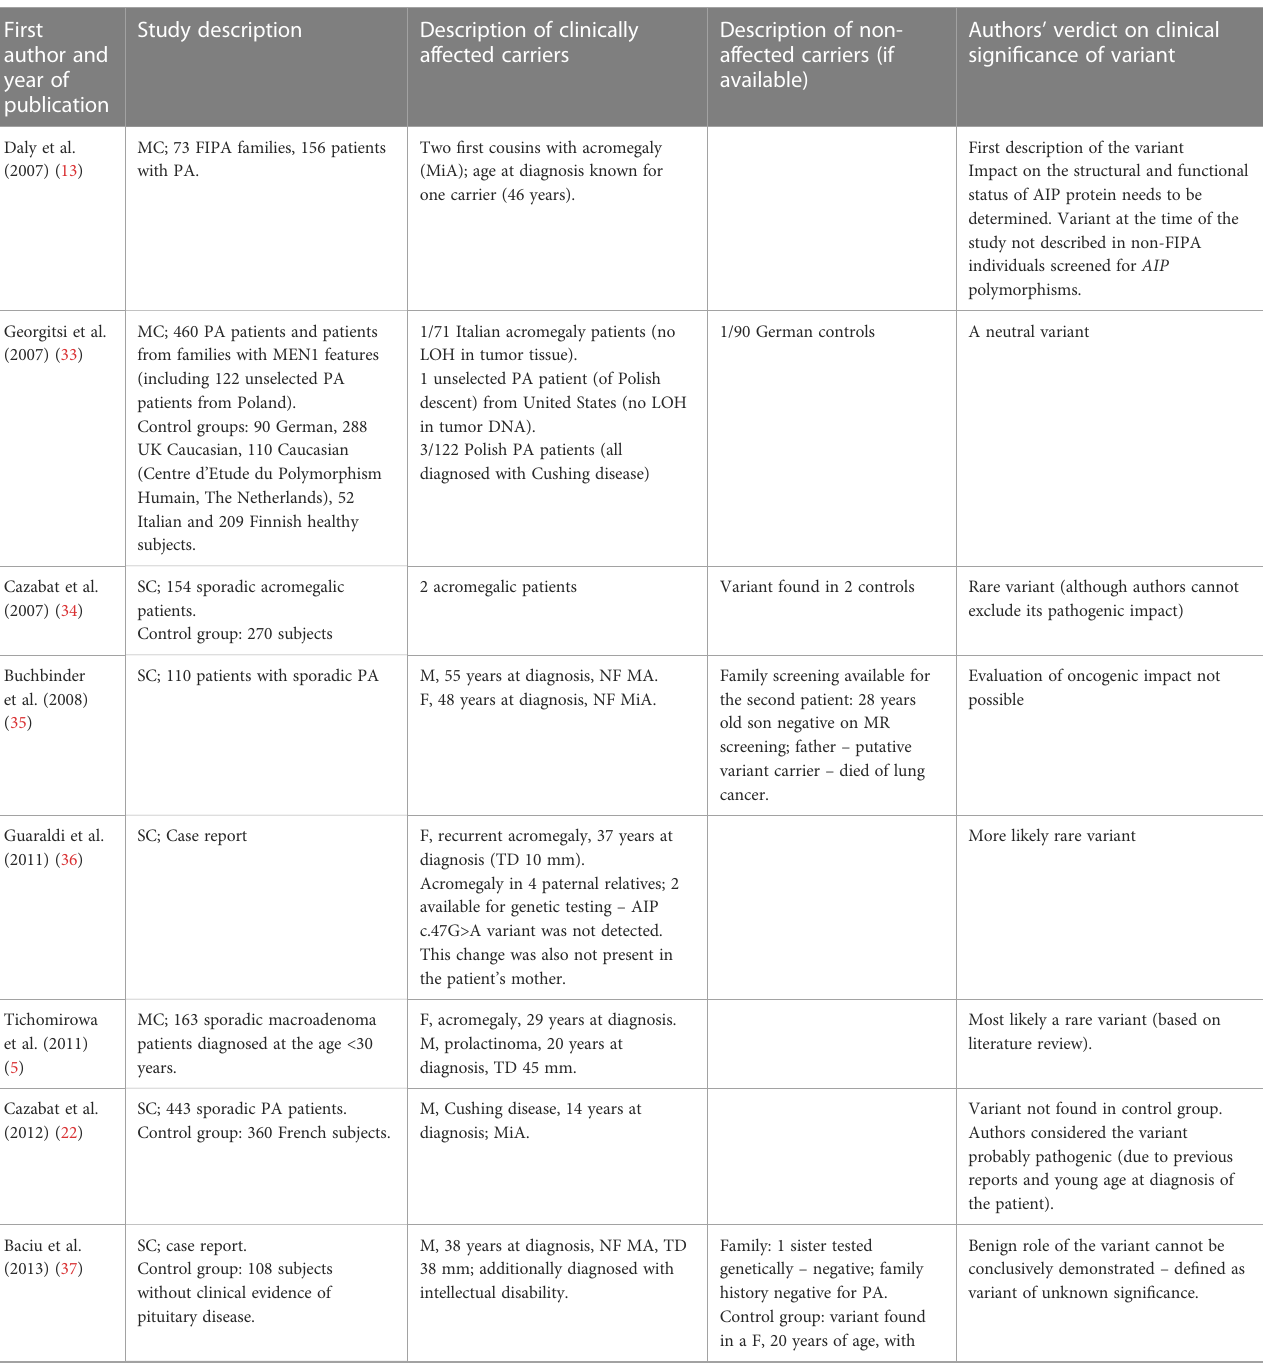
TABLE 3 Published data on clinical signi fi cance of AIP c.47G>A